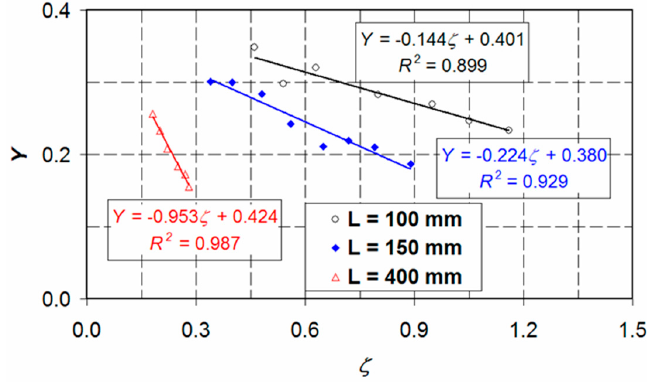
Figure 4. Normalized minimum bed pressure Y as a function of ζ for transcritical flows over trapezoidal-shaped weirs. The data of test series Pn10, Pn15, and Pn40 are indicated by black, blue, and red symbol colors, respectively.